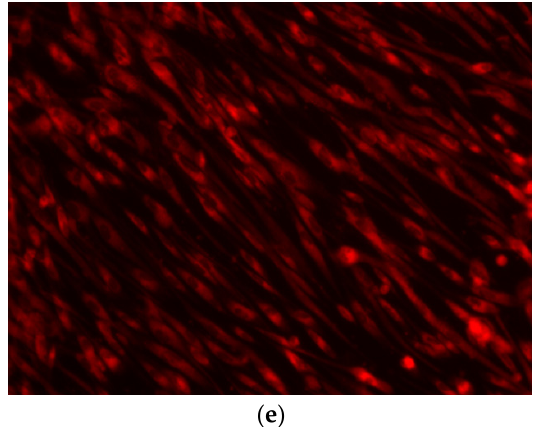
Figure 13. Fluorescence images showing the viability of HDFn cells coloured with CMTPX fluorophore: ( a ) control sample; ( b ) CC; ( c ) CC@MWCNT_TiO 2 0.01; ( d ) CC@MWCNT_TiO 2 0.025 and ( e ) CC@MWCNT_TiO 2 0.05 film